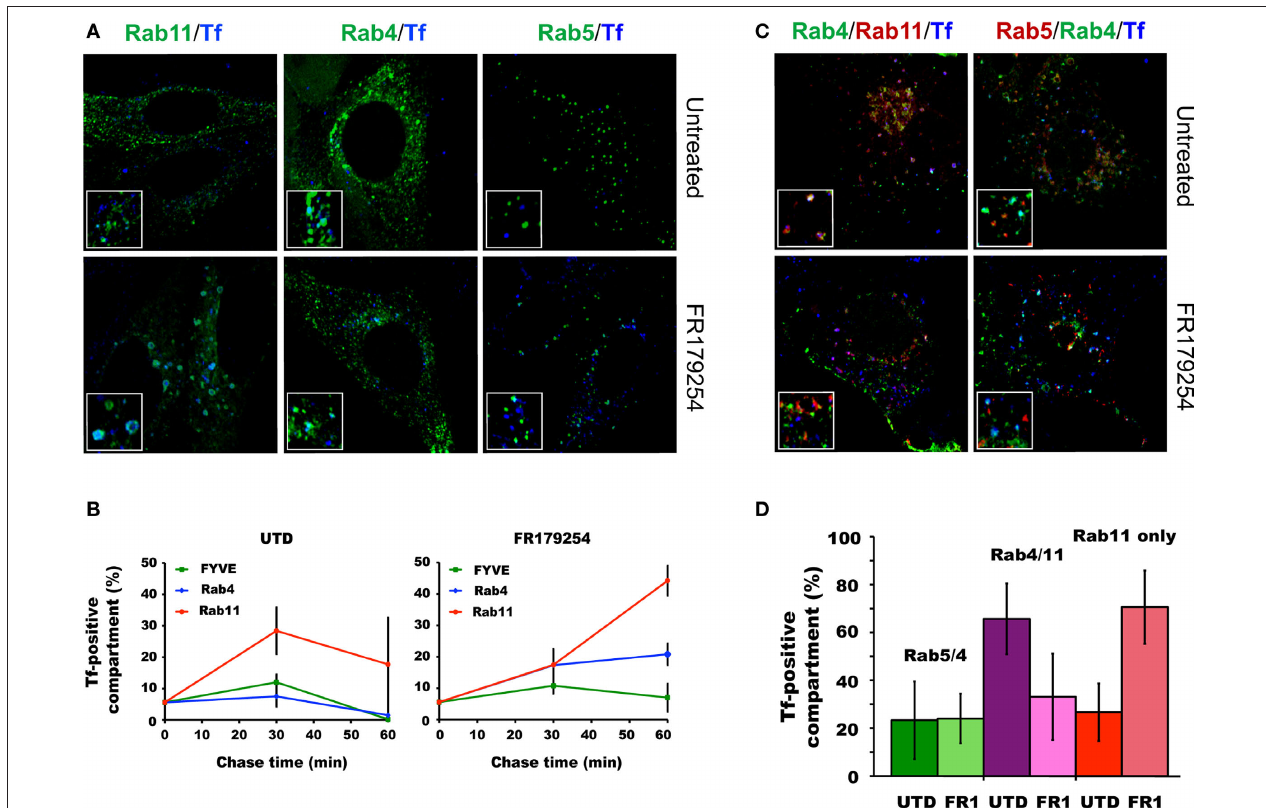
Figure 6 | Fr179254 causes a delay in the trafficking of transferrin from rab11 compartments to rab4/11 recycling compartments. Transfected cells were pulse-chased with fluorescent transferrin (Tf647) as described previously and monitored for co-localization with vesicles by confocal microscopy. Representative